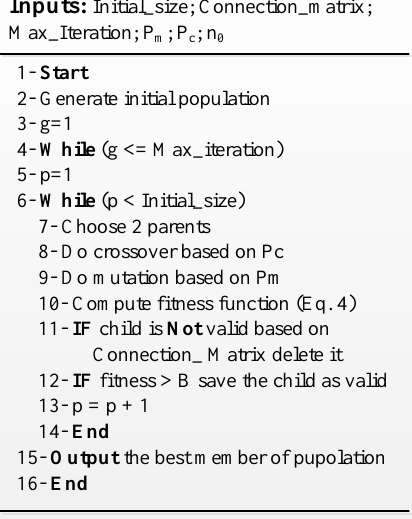
Figure 6. Pseudo code of the proposed model